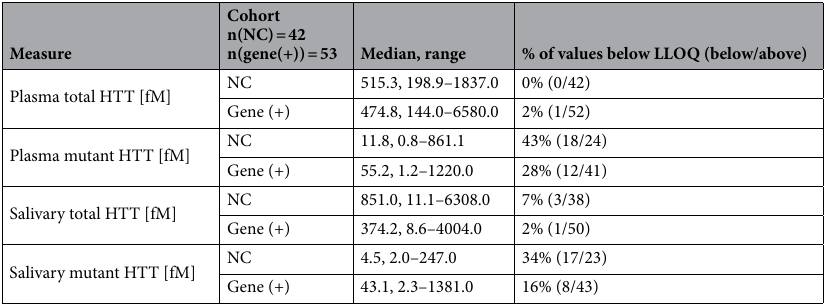
Table 1. Range of salivary and plasma total and mutant HTT values. Gene (+) participants are those with the HTT gene mutation and include PM and HD. Three saliva samples (n = 1 NC, n = 1 PM, n = 1 HD) were used for preliminary testing, and not including in